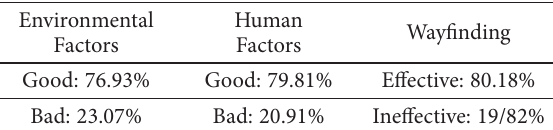
Table 2. The overall probability of wayfinding in this study, showing the probabilities of the internal nodes ‘Human Factors’ and ‘Environmental Factors’ Environmental Human Factors Factors